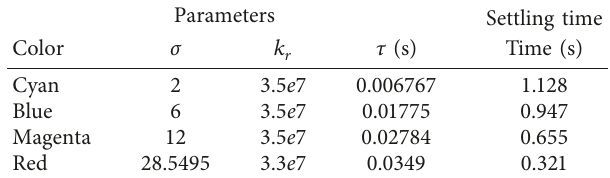
k , τ and settling time. r ( )